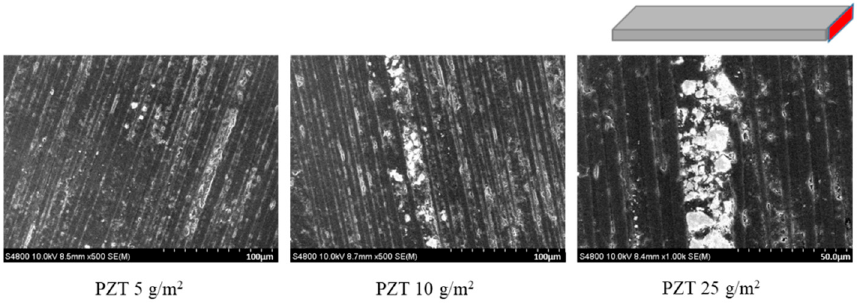
Figure 7. SEM images of fracture surfaces of the CFRP specimens with PZT specimens with different particle loadings.